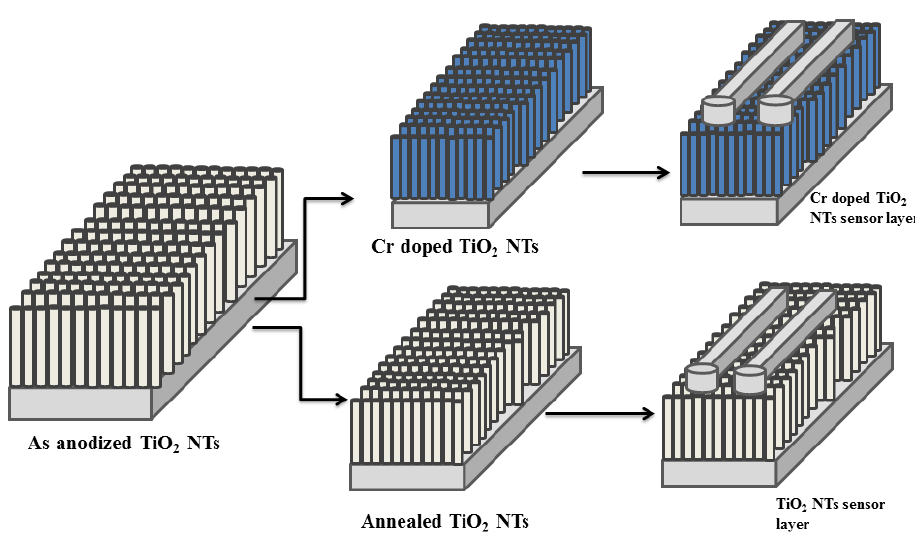
Figure 1. Schematic of nano-tubular sensor